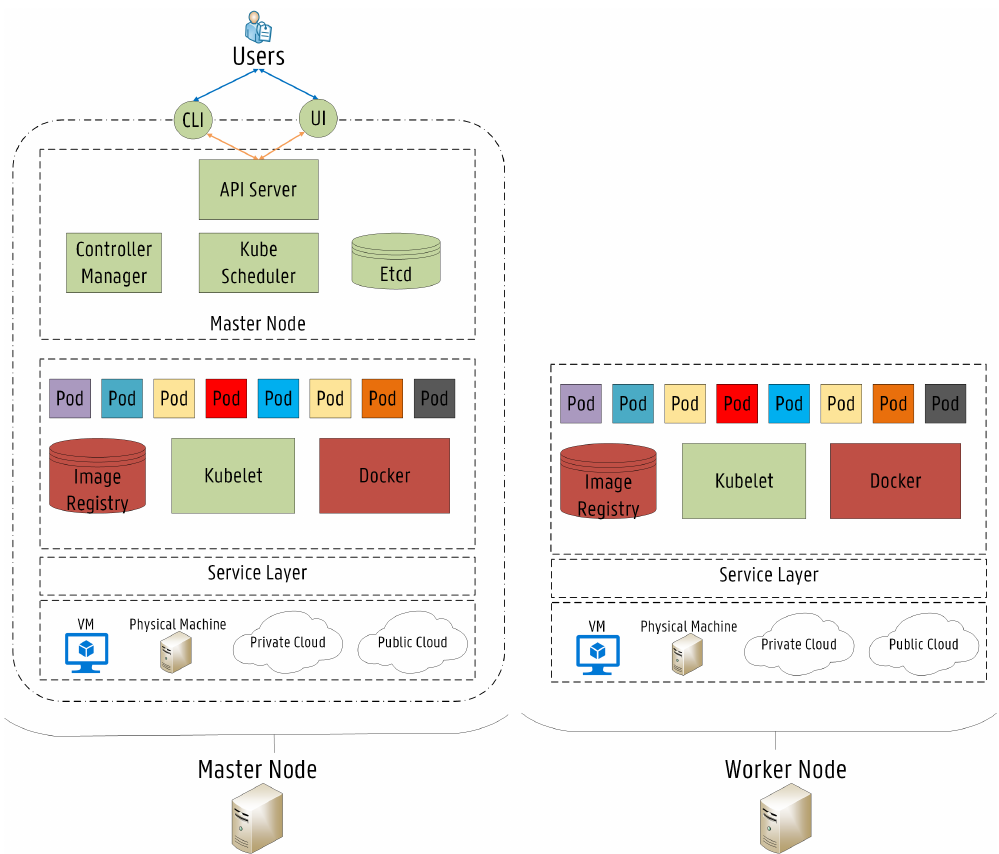
Figure 3. Detailed Architecture of the Master and the Worker Node in the Kubernetes Cluster